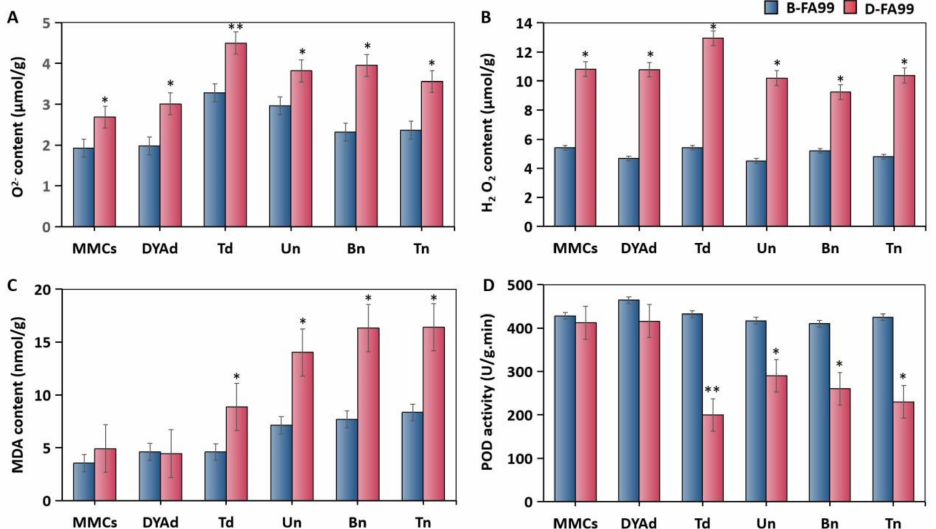
Figure 3. Analysis of FA99-related physiological indexes in different fertility environments. ( A ) O 2 −